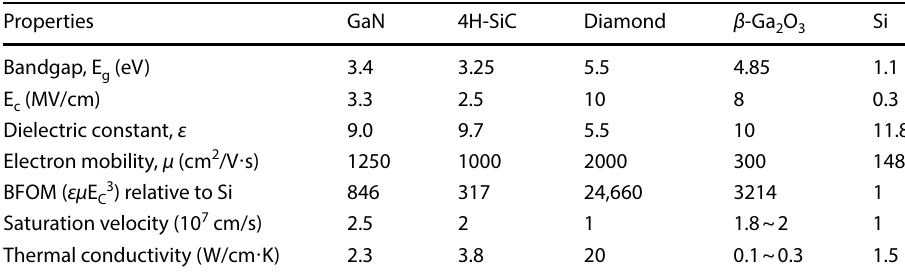
Table 1 Material properties of β -Ga O in comparison with 2 3 those of GaN, 4H-SiC, Diamond and Si (Baliga’s figure of merit: BFOM)